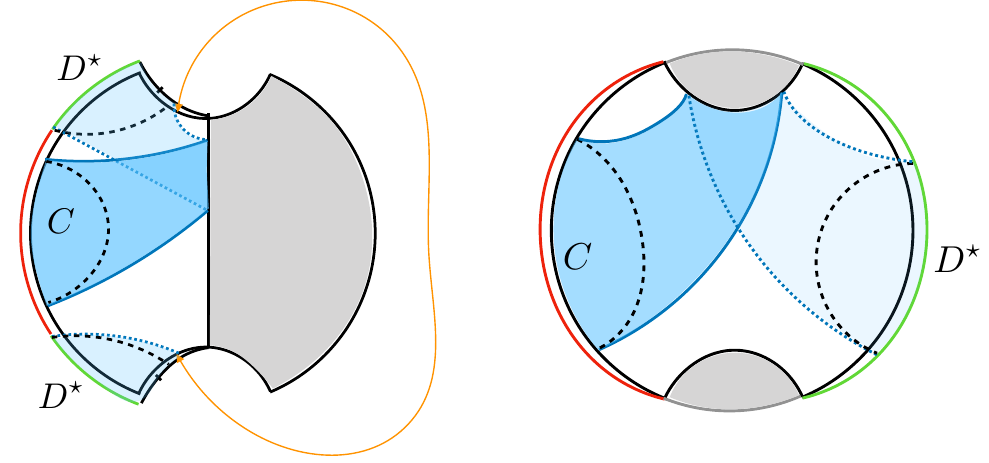
Figure 5 . Keeping the doubled entanglement wedge rr ? ( AB ) fixed we consider reduced sub-regions C, D ? and their associated minimal surface. We consider only the case where on the original copy C ∩ D = 0 . We can give the same argument as in figure 4 to show that I ( C, D ? ) = 0